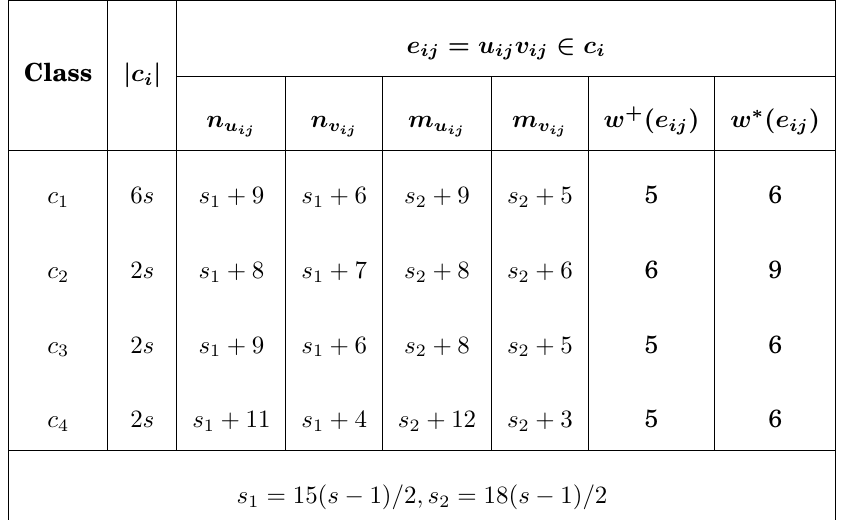
Table 1: Graph theoretical quantities of MR[ s ] /SB based on the cardinality of the closeness sets of